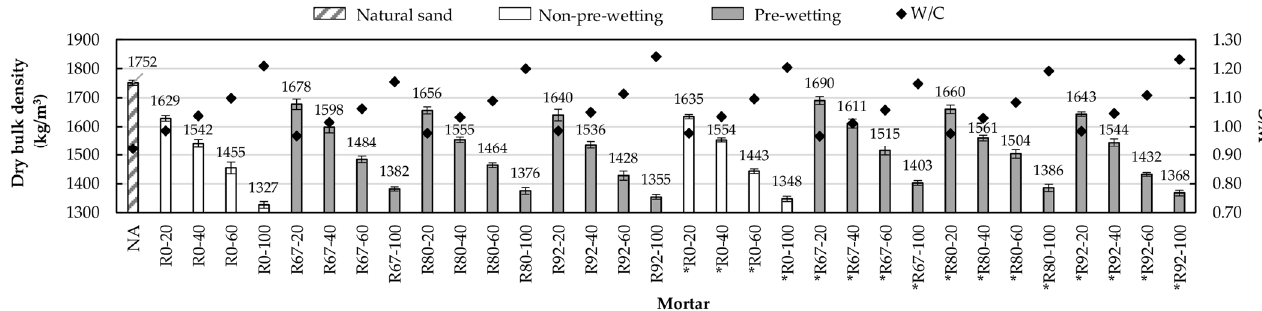
Figure 8. Dry bulk density and water/cement ratio.